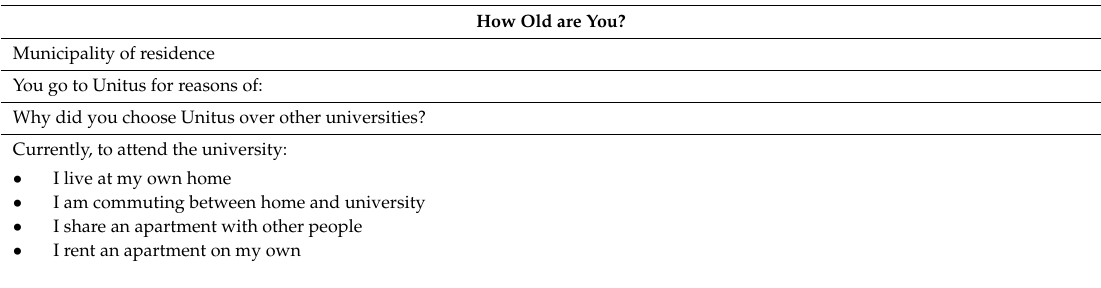
Table 2. Mobility